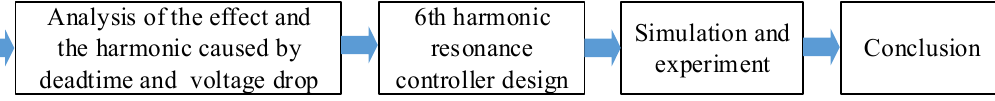
Figure 1. The chart of the research steps for this paper.